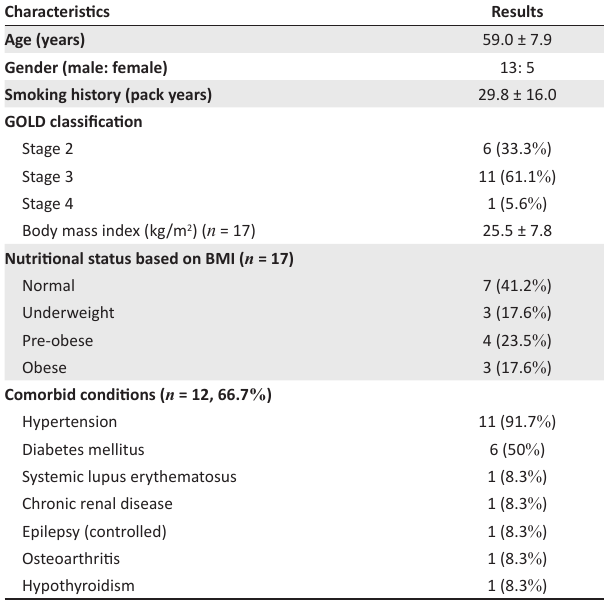
TABLE 2: Baseline participant characteristics ( n = 18).